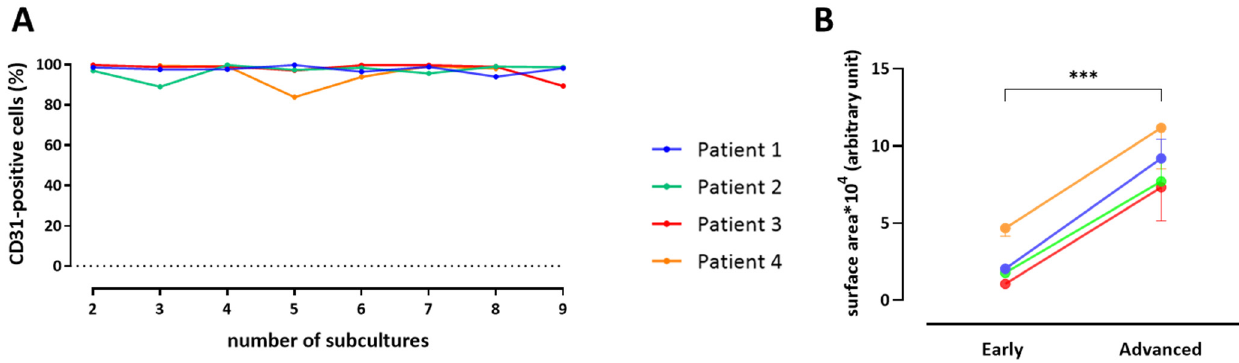
Figure 7. CD31-positive cells isolated from 4 individual patients throughout subcultures ( A ). Quantitative analysis of endothelial cell hypertrophy from 4 individual patients at early and advanced subcultures ( B ). Paired t -test, *** p = 0.0001.